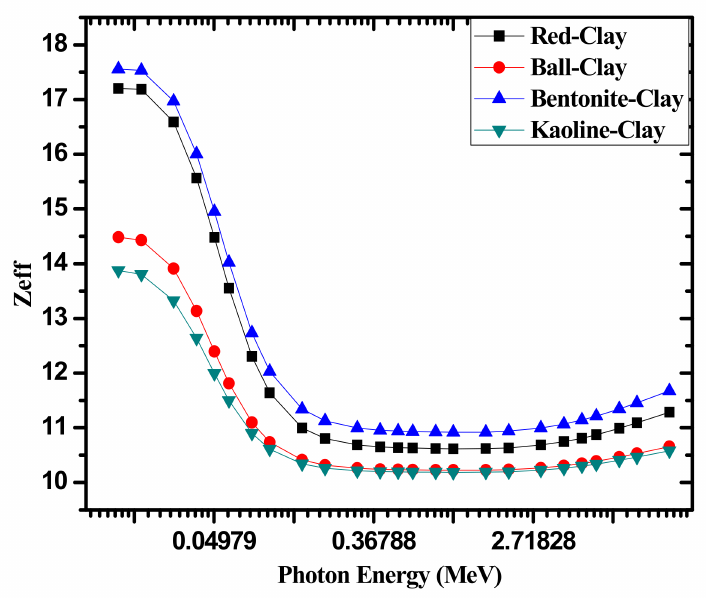
Figure 8. The effective atomic number Z eff values for the four investigated clay samples at differ- ent energies.